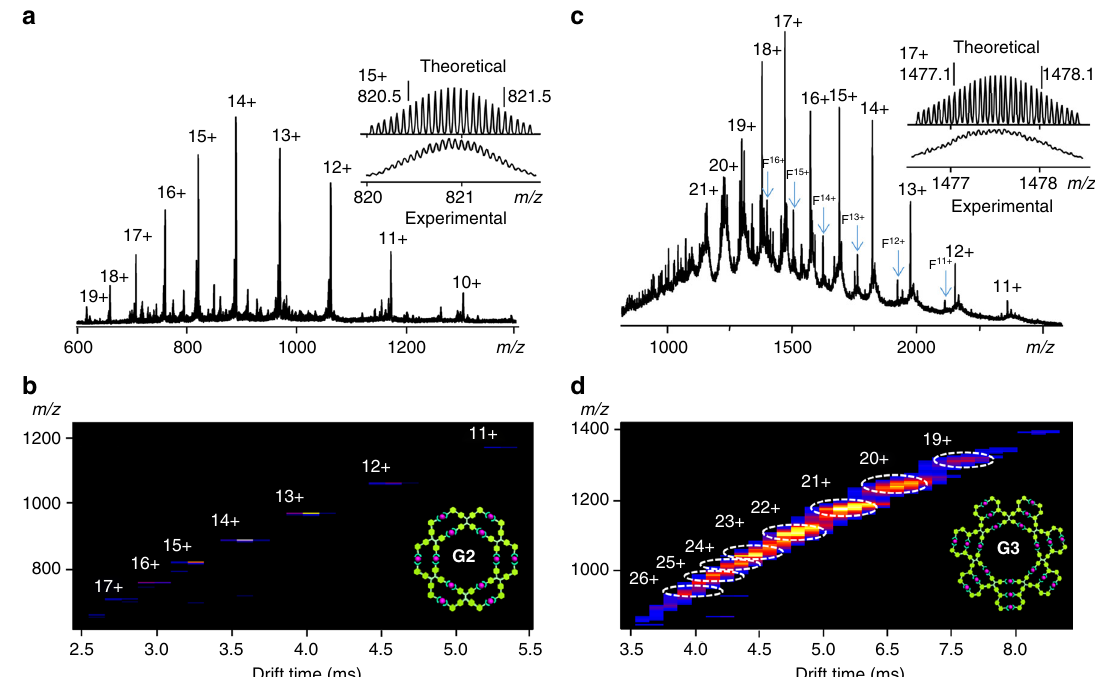
Fig. 3 ESI/TWIM-MS spectrum. a ESI-MS and b TWIM-MS plots of G2 ; c ESI-MS and d TWIM-MS plots of G3 . The peaks of F n + denote fragments [ G3 – L3 – n PF 6 − ] n